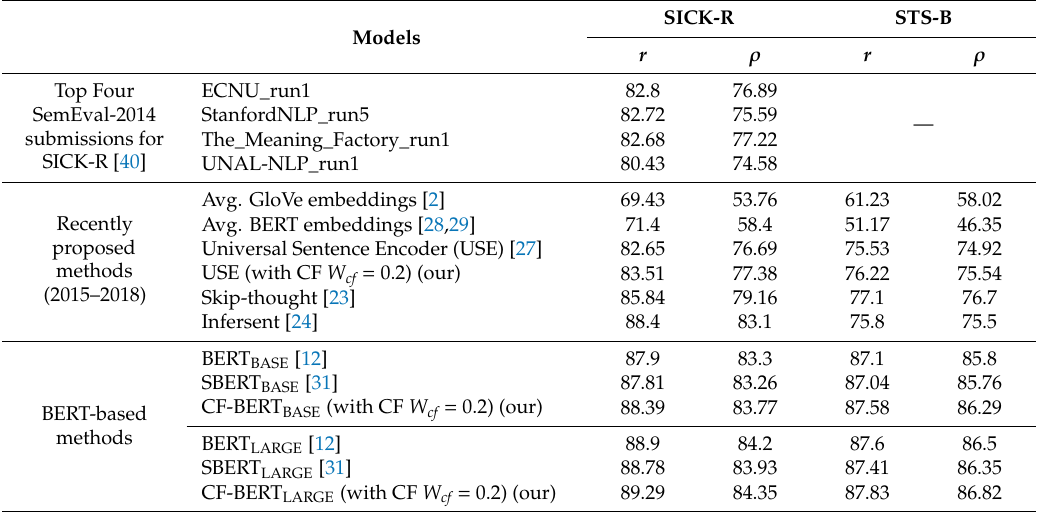
Table 5. Test set Pearson correlations ( r ) and Spearman correlations ( ρ ) for STS